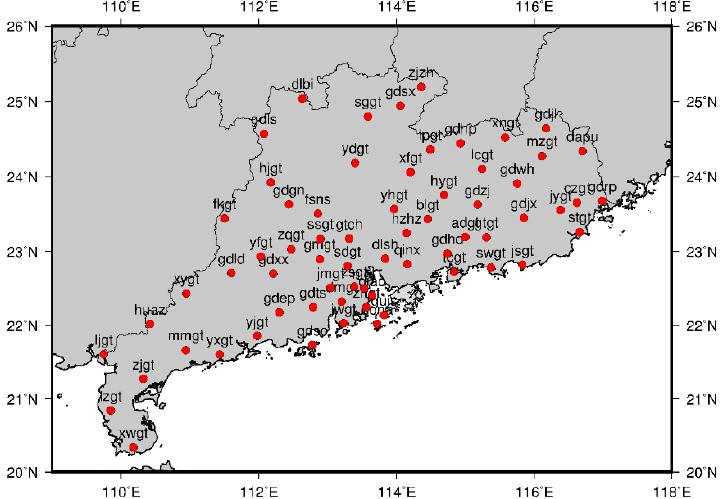
Figure 1. Distribution Map of Continuously Operating Reference Stations (CORS) Station in Guangdong Province.